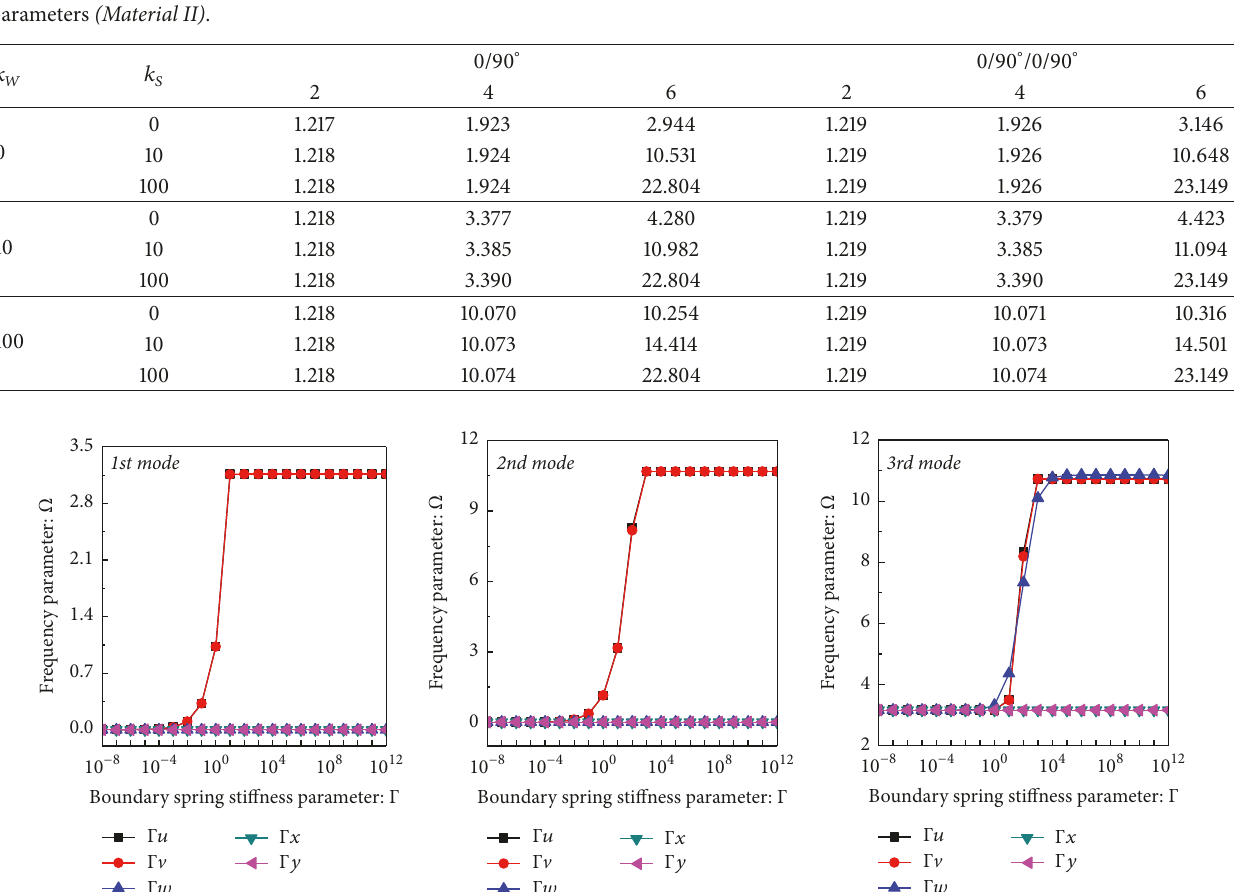
Figure 7: Frequency parameters Ω versus elastic parameter Γ for the plate with 8-point supported boundary conditions.